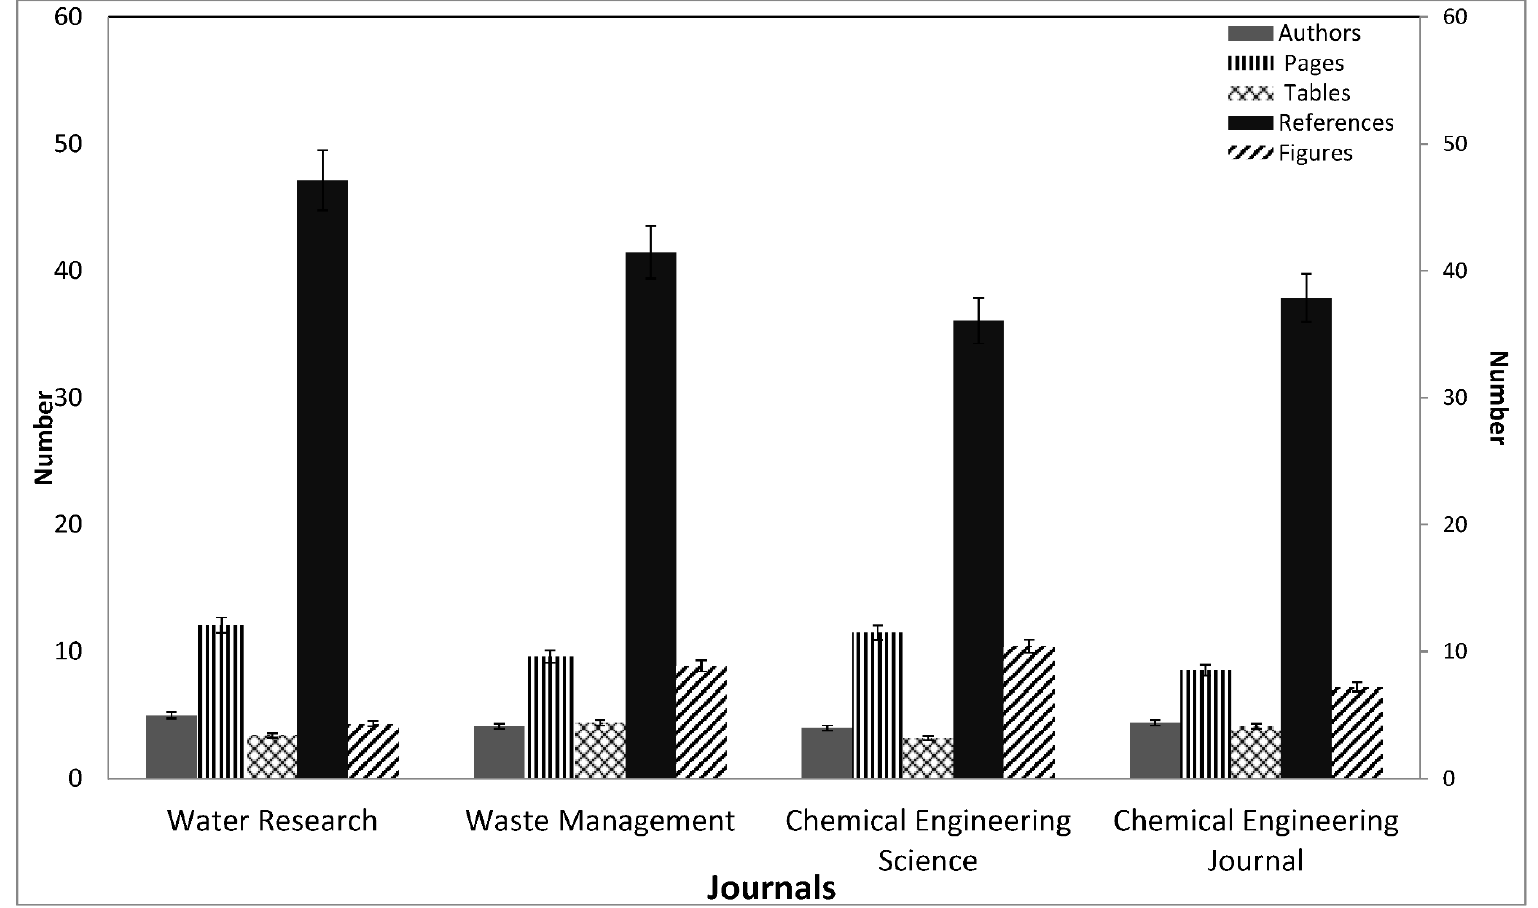
Figure 2. Volumetric characteristics of the analysed published papers, including number of authors, pages, tables, references and figures per journal.